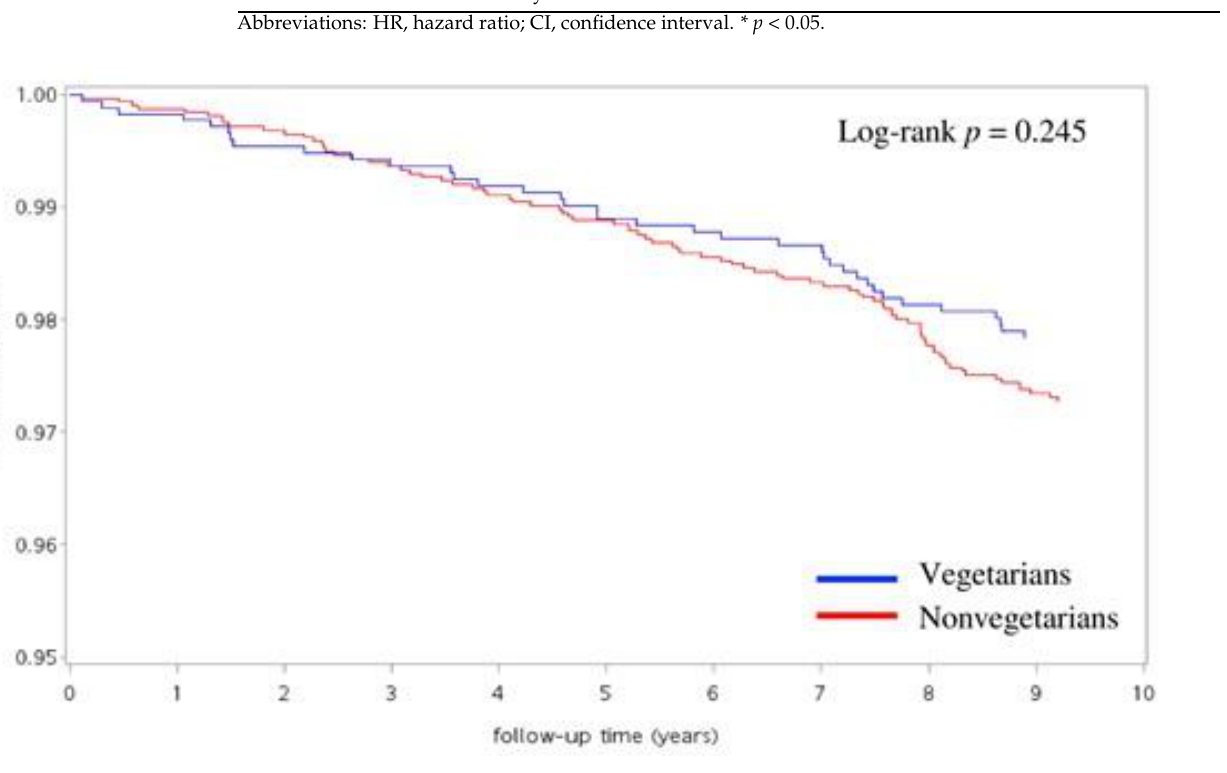
Figure 2. Cumulative incidence of dementia between vegetarians and nonvegetarians during a 10-year follow-up period. Table 4. Risk of developing dementia in vegetarians compared with nonvegetarians in age sub-